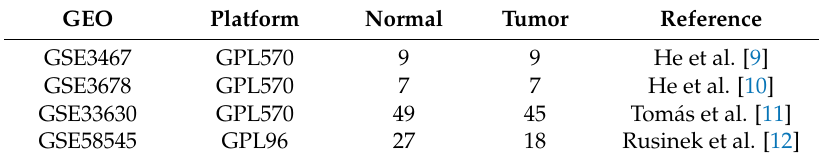
Table 1. Samples distribution of papillary thyroid carcinoma (PTC)